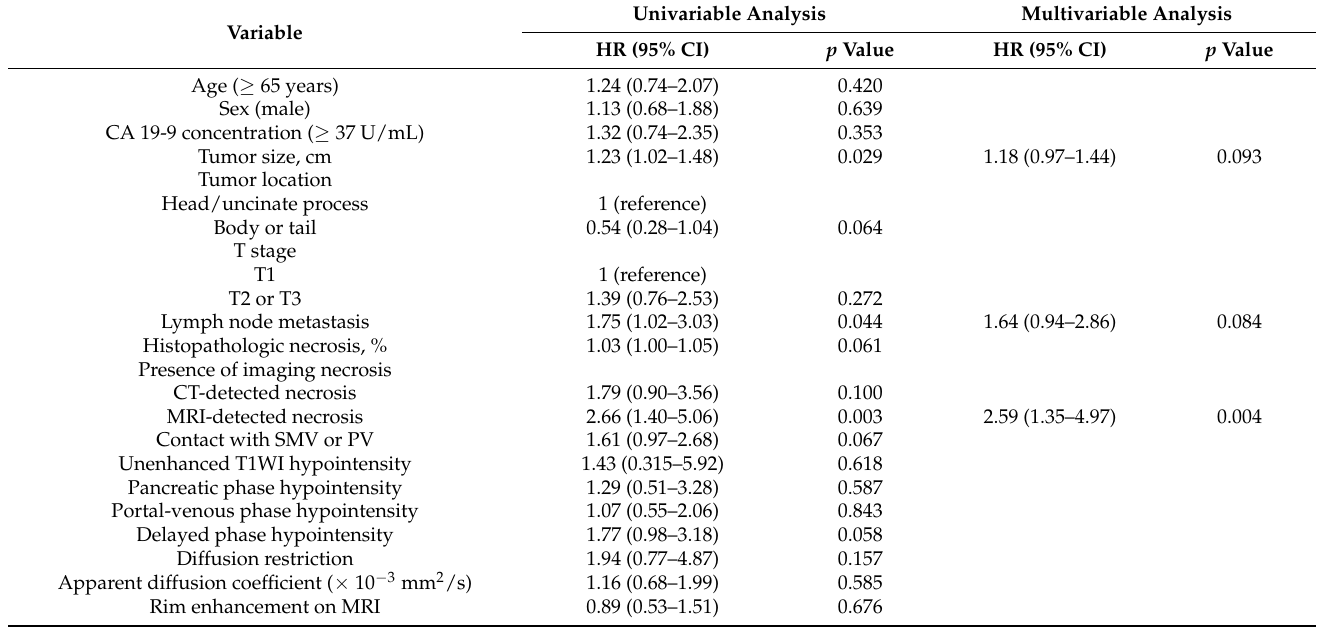
Table 4. Univariable and multivariable Cox proportional hazard analyses for overall survival after